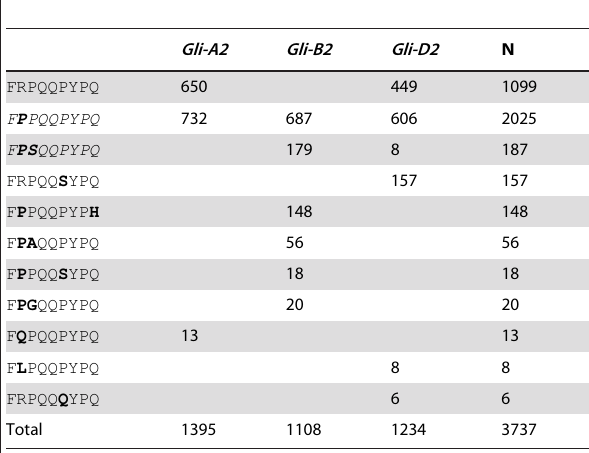
Table 4. DQ2-Glia- a 3 epitope variants expressed in bread wheat.